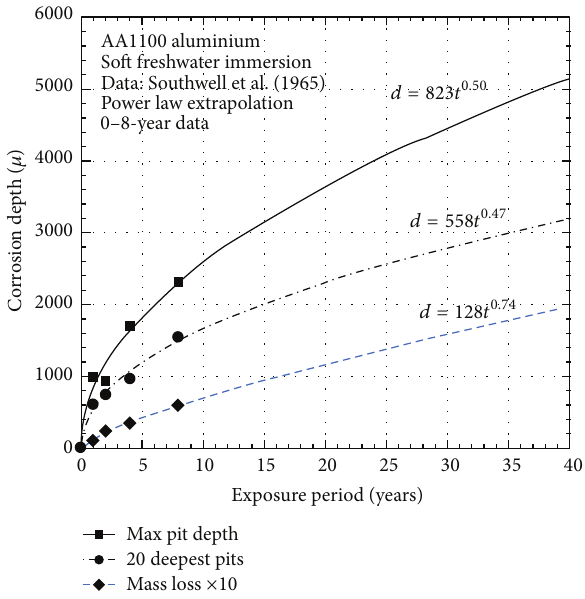
Figure 18: Data for AA1100 in freshwater shown in Figure 10 with a power law fitted to data for only the period 0–8 years and then extrapolated to 40 years. The expressions for each fitted power law function are shown. Note change in vertical axis compared with Figures 16 and